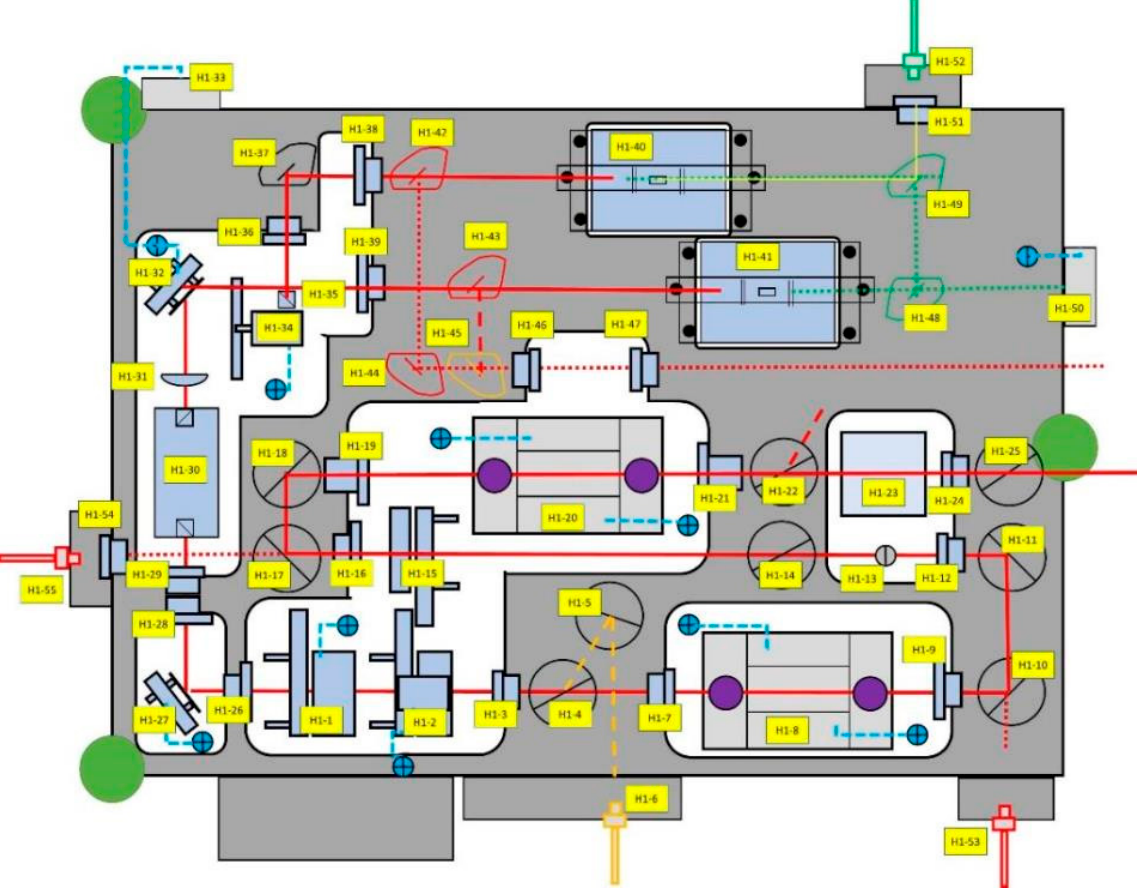
Figure 3. Schematic of the pump laser system (housing 1; the size of the monolithic head 40 × 57 cm²).